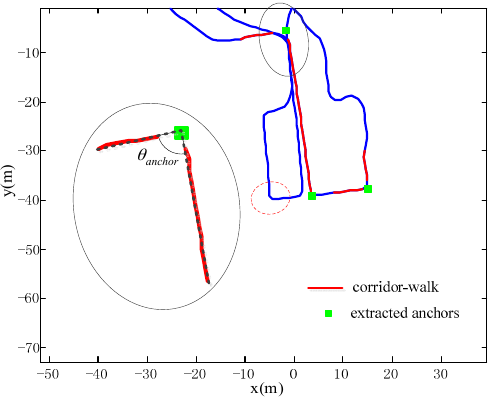
Figure 4. An example of anchor extraction from corridor-walks.